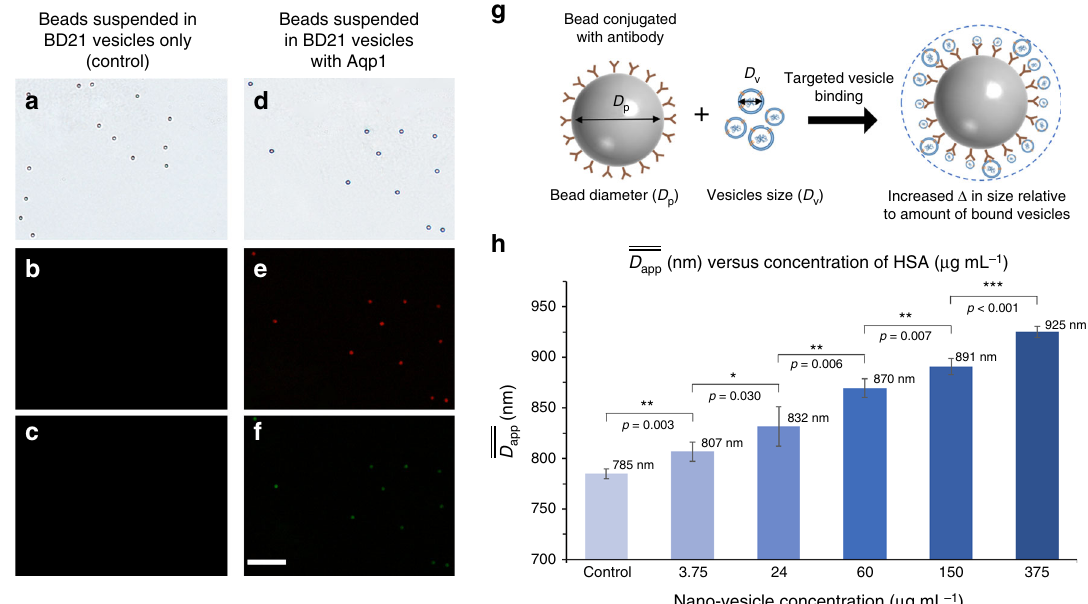
Fig. 7 Vesicle detection using antibody immobilised beads. PS-COOH beads (1 µ m) conjugated with Aquaporin-1 (Aqp1) antibody incubated with BD21 vesicles without Aqp1 protein showing no binding of vesicles a – c . The speci fi c binding of BD21 vesicles containing Aqp1 protein on the anti-Aqp1-beads as con fi rmed by fl uorescence from RBOE dye in vesicles in e . Fluorescence from Alexa- fl uor 488-labelled secondary antibody further con fi rmed the presence of Aqp1 in vesicles bound to the anti-Aqp1-beads f . Scale bar is 10 µ m. g Schematics showing the detection based on the change in size due to the binding of vesicles onto the antibody-conjugated beads. The buffer media used here is 0.1 × PBS solution. h The detection of vesicle concentrations of 3.75 – 375 µ g mL − 1 was performed with four sets of samples ( n = 4) with SD as the error bars. Independent two-sample t -test is used for the statistical analysis where * p < 0.05, ** p < 0.01, and *** p <